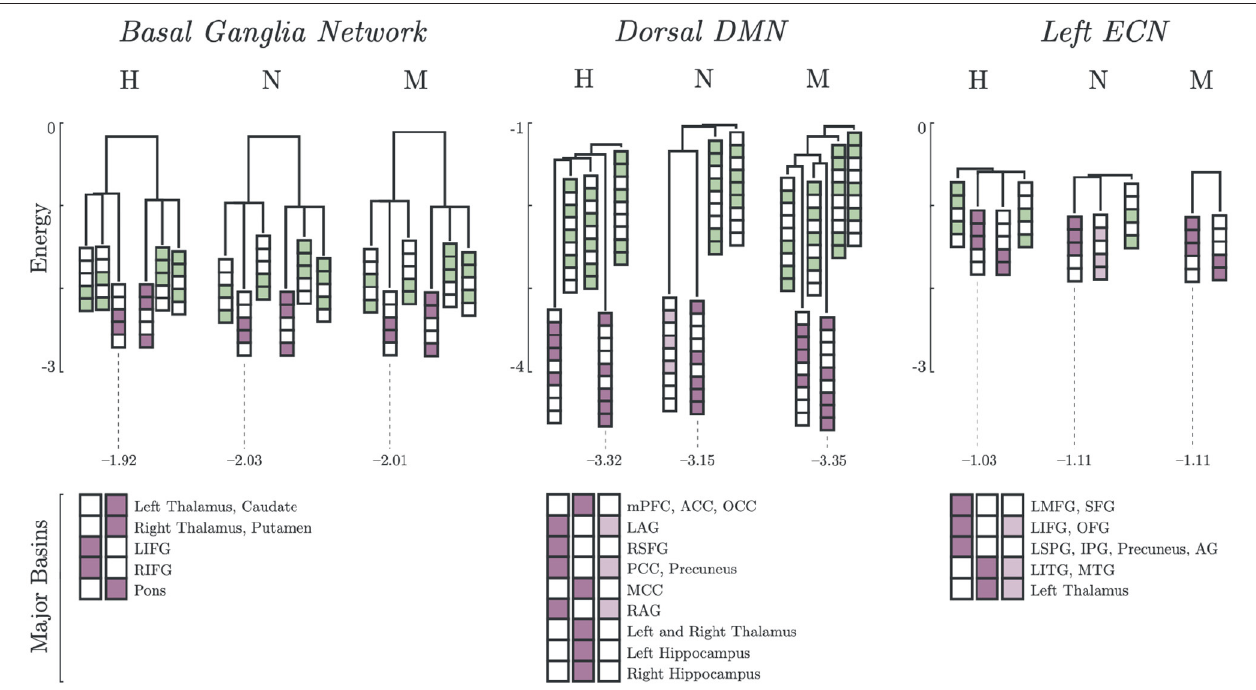
FIGURE 2 | Major and minor basin states. Major basin states (purple) and minor basin states (green) for Healthy, Non-Melancholic, and Melancholic groups on BGN, DDMN, and LECN. For each state, colored boxes correspond to activated regions, while white boxes are inactive. Energies of the deepest major basins for each group are also indicated (see Supplementary Table 3 for summary of all major basin